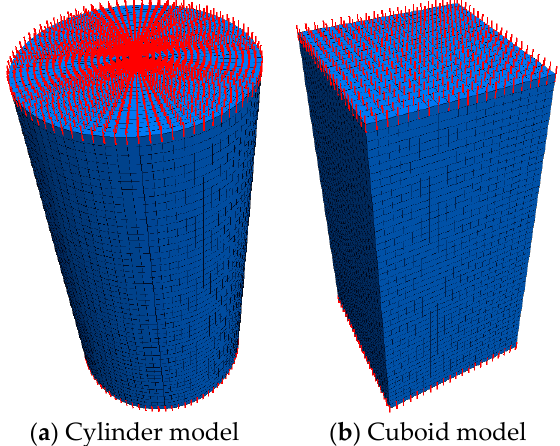
Figure 7. Mesh generation and boundary conditions of the computational model.